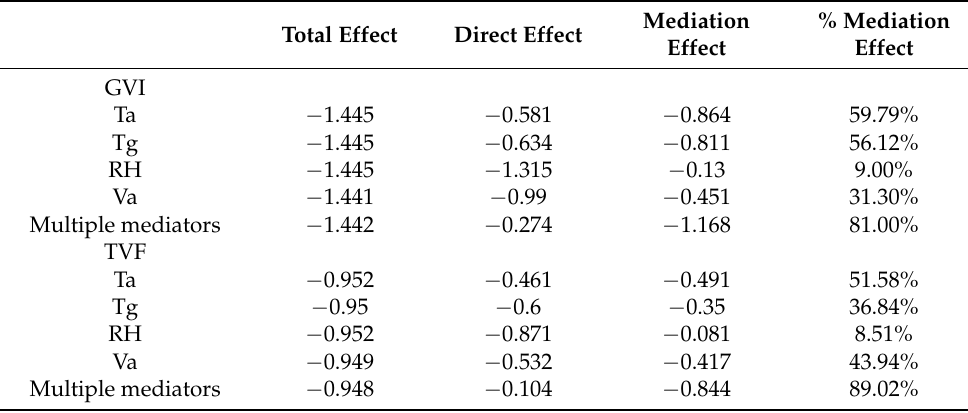
Table 5. Total, direct, and mediation effects of the mediation